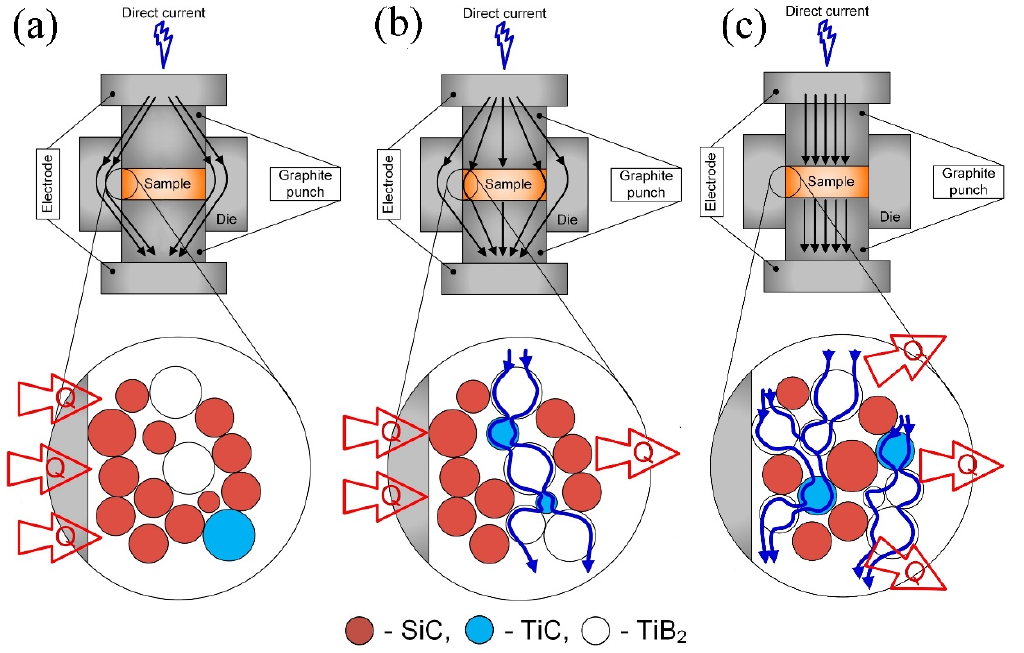
Figure 7. Schemes of the processes that take place during SPS of ( a ) 80SiC, ( b ) 60SiC, and ( c ) 40SiC composites.